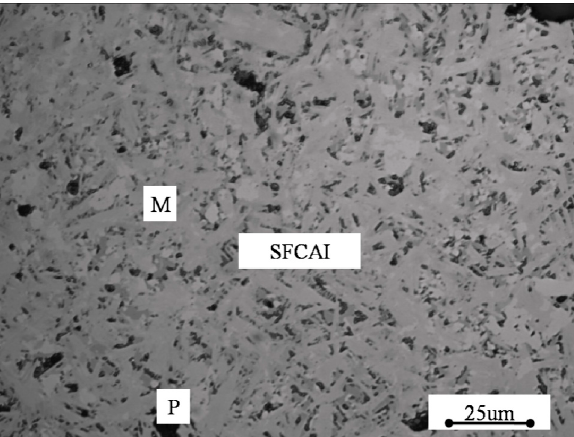
Figure 8. SEM images of a high-basicity (R = 2.6) PVTM sinter.